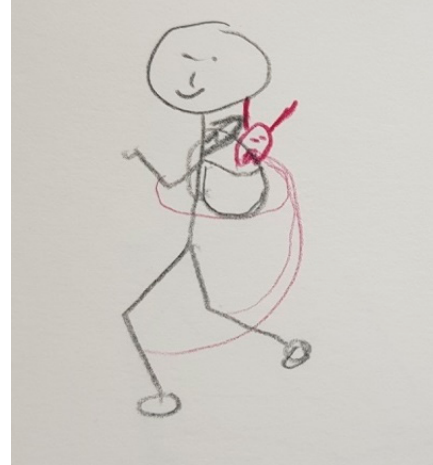
Figure 14. P5’s perception of DBS’s effect.